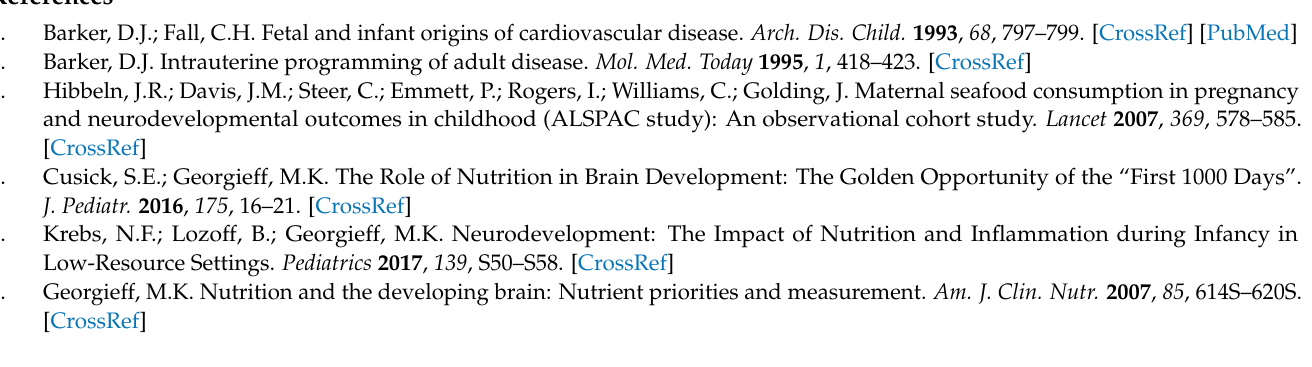
Table S1: Operating conditions used for Se determination by ICP-MS/MS; Figure S1: Body weight (A) and body length (B) in pups assessed on post-natal day (PND) 4, 7, 10 and 12; Figure S2: Anxiety-like behavior in Light/Dark test (A,B) and latency to fall in Rotarod test (C) in juvenile